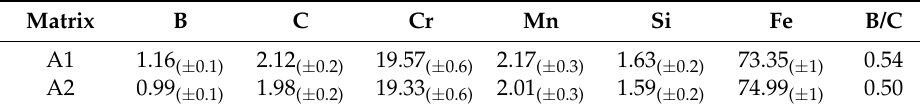
Table 3. Compositions of the martensite measured by using EPMA.